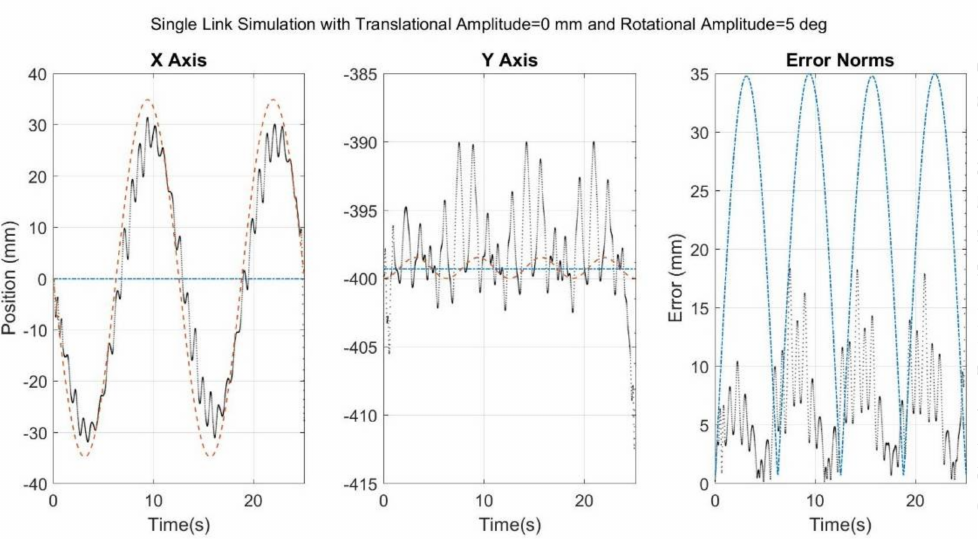
Figure 8. Results for simulation run with noise added to a rigid link as well as induced relative rotational motion of the sensor. Black dots refer to SFO, blue dash-dots to SOM, and red dashes to the